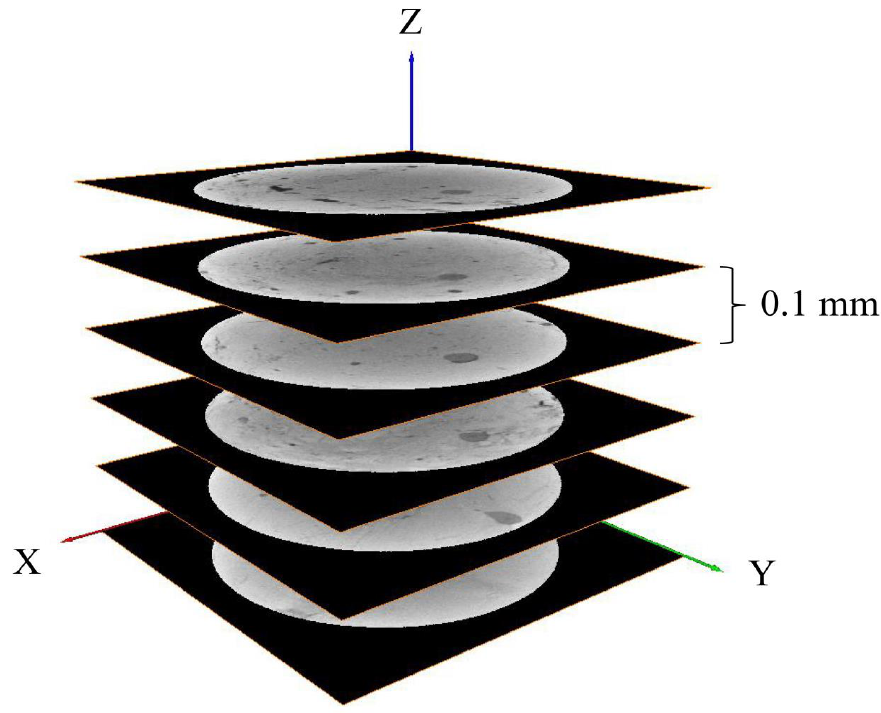
Figure 2. Slices obtained from whole soil columns.